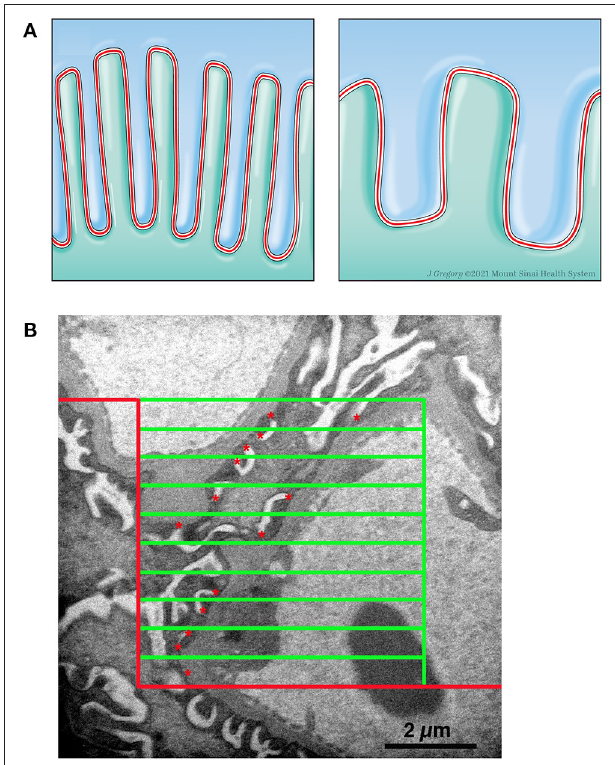
FIGURE 3 | Measurement of length density of slit diaphragm. (A) Left Panel . Schematic drawing of two podocytes (green and blue) with normal interdigitating foot processes and the slit diaphragm (red line) between them. Right Panel . Schematic drawing of effacement with shortening of slit diaphragm. (B) Electron micrograph with line grid used to measure Ls. A counting frame was superimposed over a high magnification image. The frame consists of a peripheral guard zone, inclusion lines (vertical green line and upper horizontal green line), exclusion lines (red lines), and 10 counting lines (green horizontal lines). The number of times a counting line intersects the podocytes-GBM interface was counted and the number of slit diaphragm profiles (red *) within the counting frame and not touching the exclusion line was